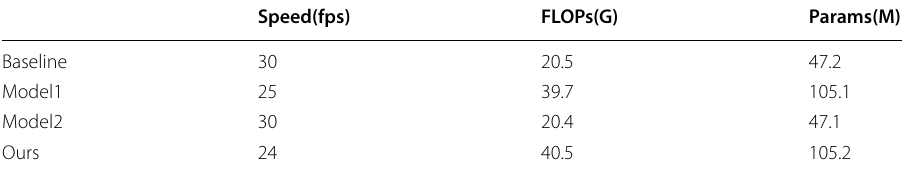
Table 5 Comparison about the speed, FLOPs, and